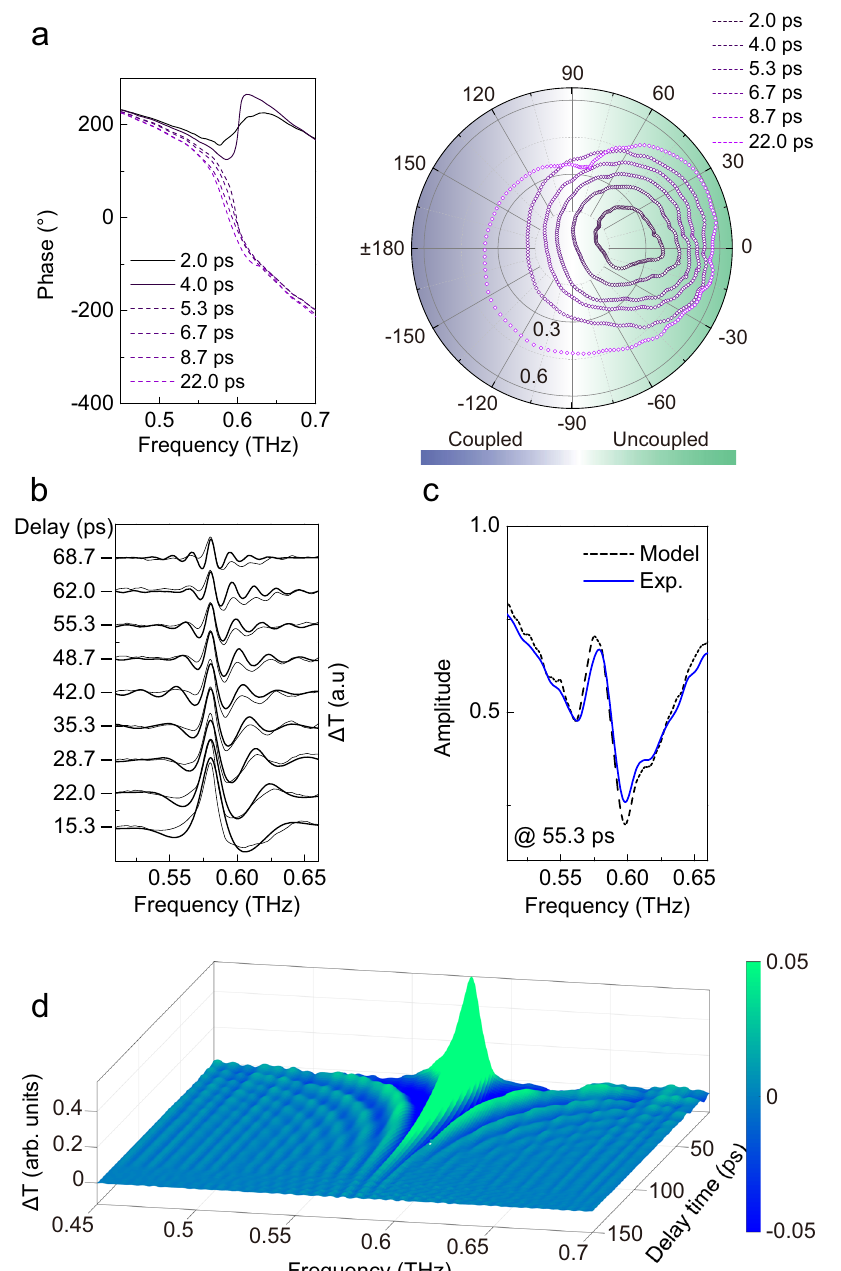
Fig. 4 Transition of coupled cavity and temporal two-dipole model. a Phase spectra and the parametric polar plot of transmission for the cavity at various delays indicating the transition of coupled regime. b Comparison of experimental and calculated spectra with the temporal two-dipole model. Most of the spectral features are well reproduced in the calculation. c Reproduce the experimental transmission spectrum by applying the model to the experimental pro fi le at steady state with t p = 55.3 ps. d Full modulation spectra at various delay times by applying the model to the temporal pro fi le of sample at steady state. Color bar was preset within a small range for a larger color